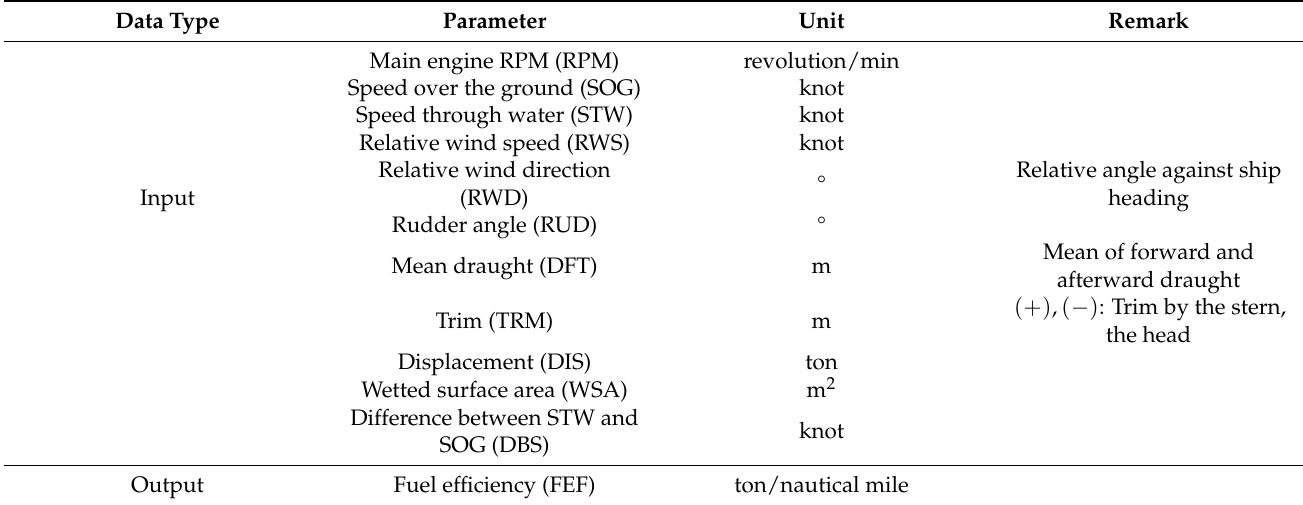
Table 3. Ship parameters used in the study to predict fuel